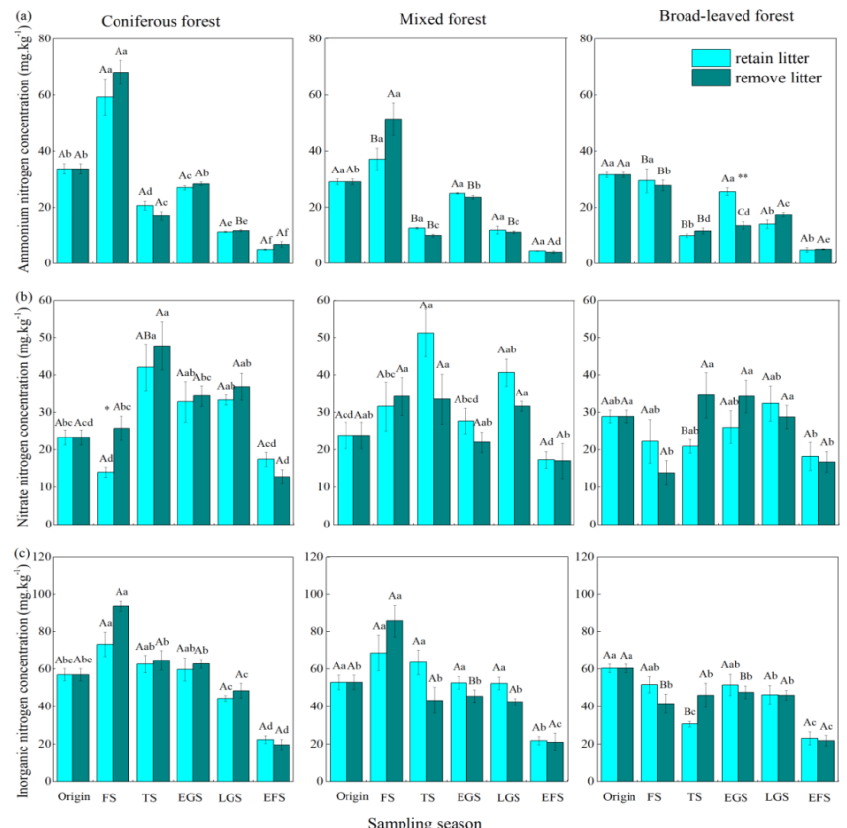
Figure 2. Concentrations of soil ammonium nitrogen, nitrate-nitrogen, and inorganic nitrogen as affected by litter treatment at different sampling seasons in coniferous ( a ), mixed ( b ), and broad-leaved ( c ) forests. Values indicate the means ± standard error, n = 3. FS: freezing season, TS: thawing season, EGS: early growing season, LGS: late growing season, EFS: early freezing season. Asterisks represent the significant differences between different litter treatments in the same forest type and sampling season. Lowercase letters represent significant differences among different sampling seasons in the same litter treatment and forest type. Uppercase letters represent significant differences among different forest types in the same litter treatment and sampling season.